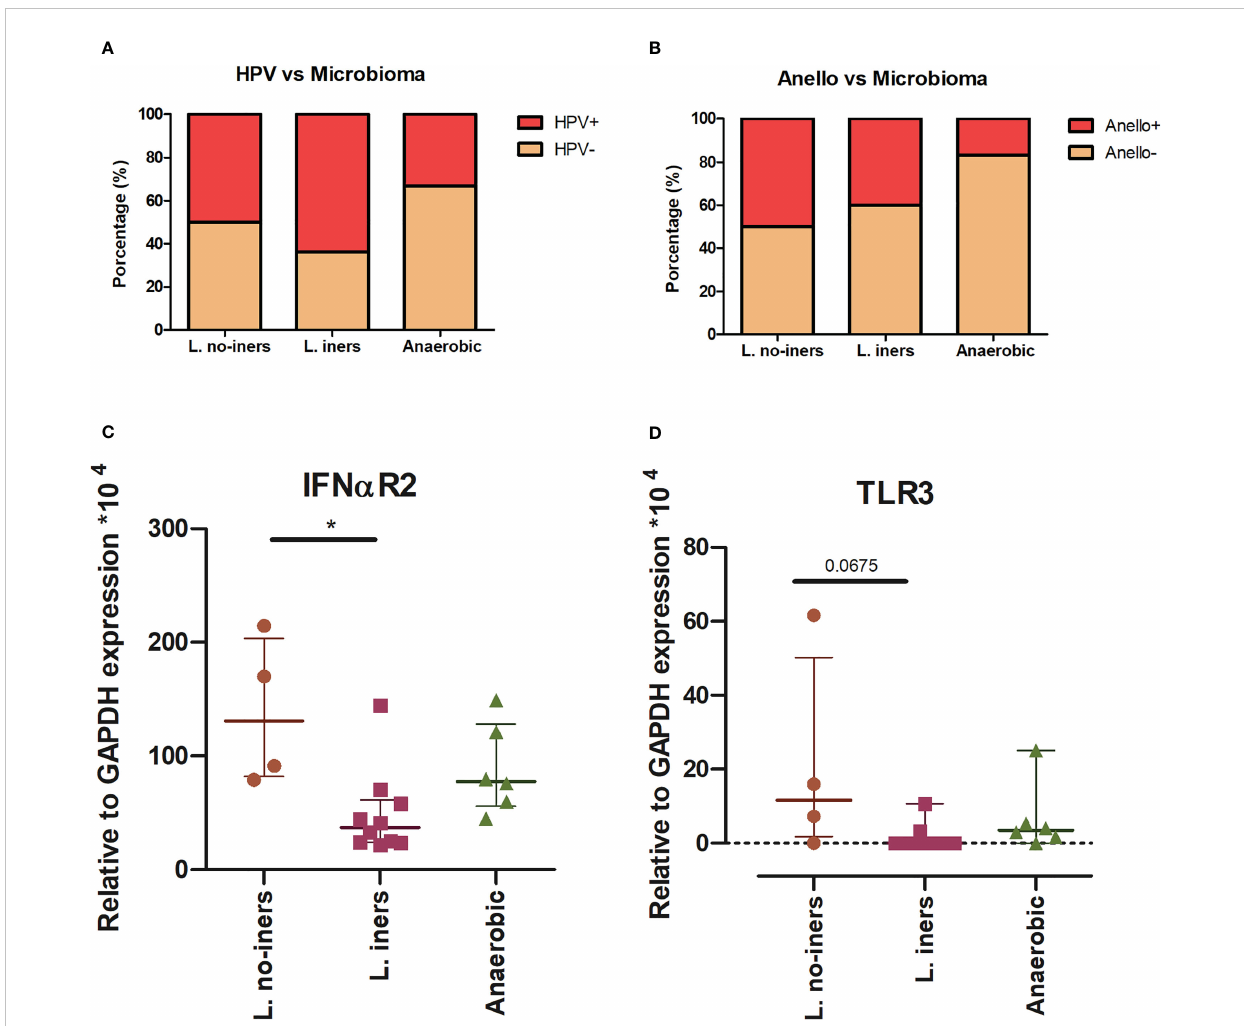
FIGURE 3 CST distribution related to virus status (A, B) and gene expression (C, D) . Stacked bar graph of grouped CSTs showing the percentage of HPV (A) and Annelovirus (B) infected and non-infected patients. Statistical Test: qui-square. Scatter plot of IFN a R2 (C) and TLR3 (D) expression in L. no-iners, L. iners and No-Lacto groups. Central horizontal bars represent the median and upper and lower horizontal bars the interquartile range. We show only genes for which we rejected null hypothesis (Kruskal-Wallis test, (C) p = 0.0019 and (D) p = 0.0291). We performed Dunn ’ s multiple comparisons as a post-hoc test (* - p <